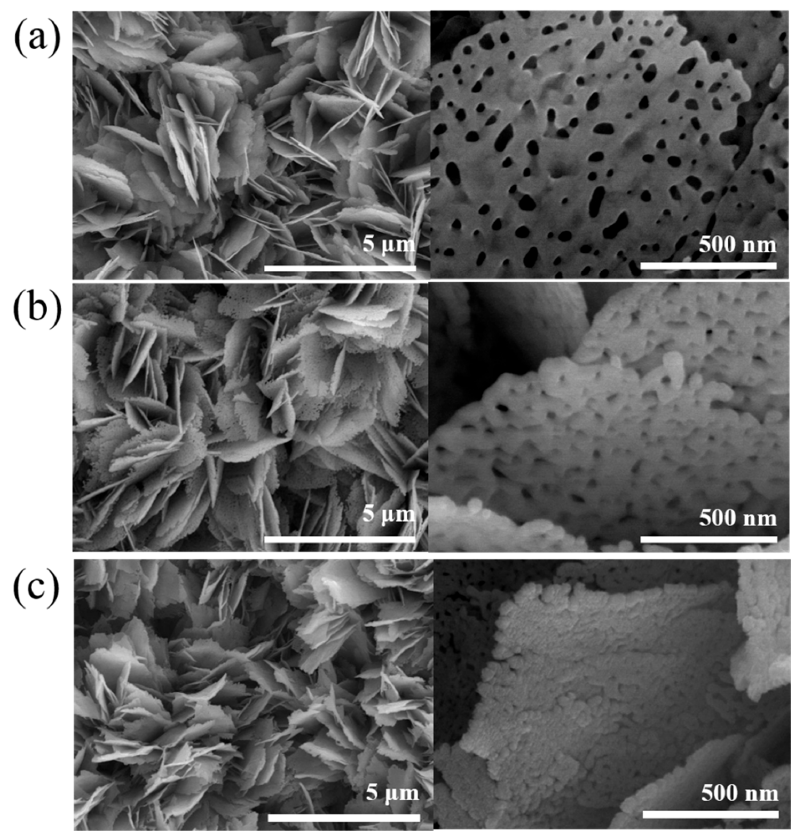
Figure 1. ( a ) SEM micrograph of the pristine porous ZnO nanosheets. The SEM micrographs of the porous ZnO-NiO composite nanosheets: ( b) ZnO-NiO-1 and ( c ) ZnO-NiO-2.